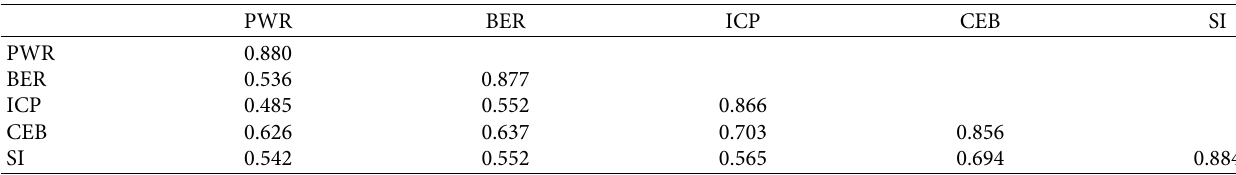
Table 6: Discriminant validity.